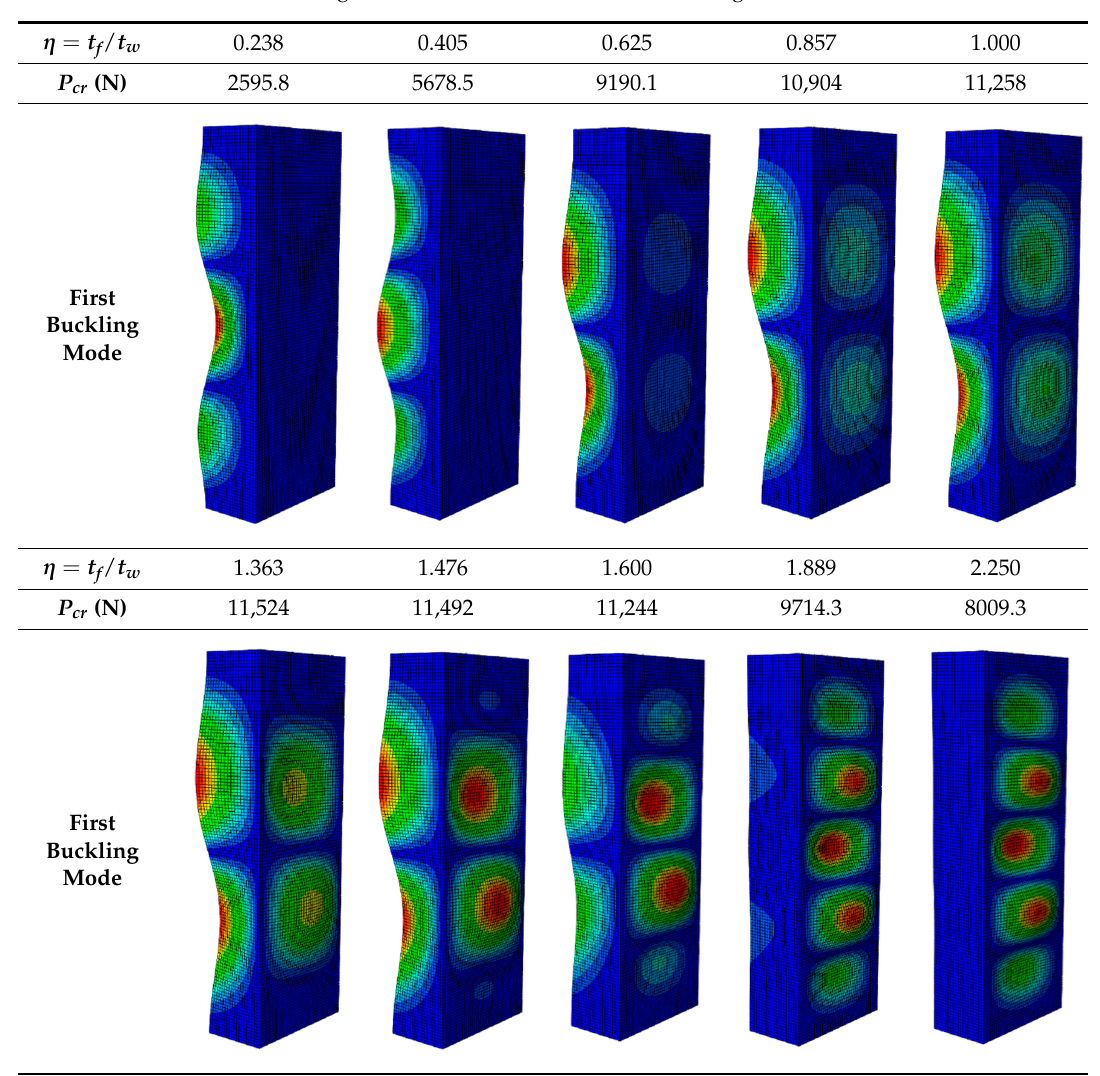
Table 5. First Buckling Modes of the Strut with Different Flange/web Thickness Ratios.